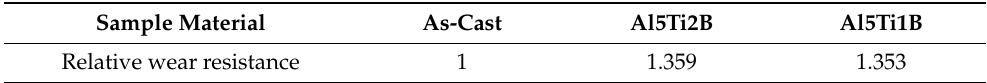
Table 4. Relative wear resistance.